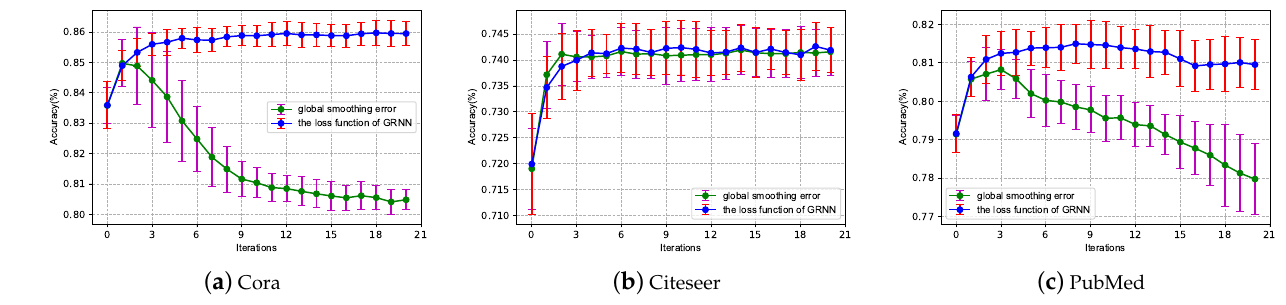
Figure 2. Ablation study on the loss function and number of iterations.